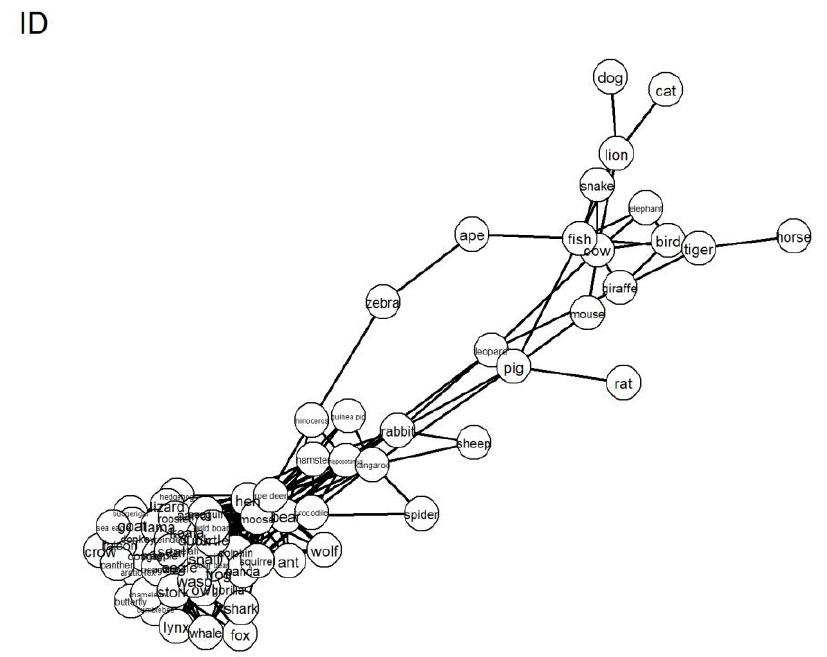
Figure 2. Graphical representation of the semantic network of the adolescents with ID.